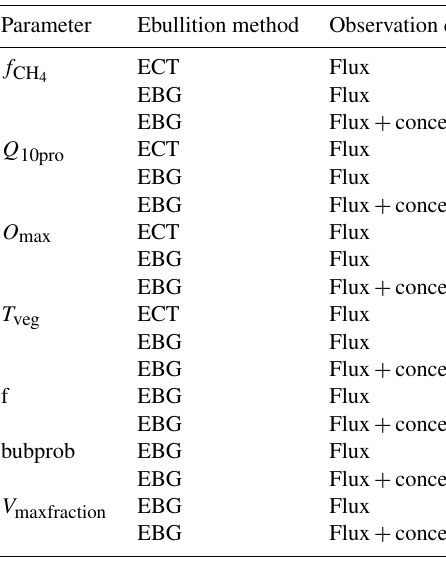
Table 4. Parameter values for the posterior distribution of